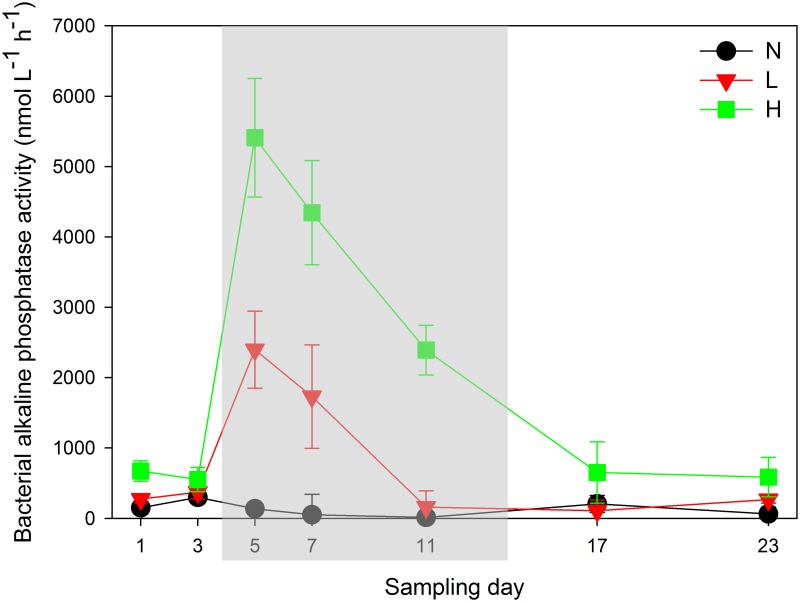
Variations of bacterial alkaline phosphatase activity in different experimental groups.N, L and H in the legend represent the three groups with ~15, ~150 and ~1500μg L-1 chlorophyll-a, respectively. The grey shadow emphasizes the peak values of bacterial alkaline phosphatase activity in this experiment.